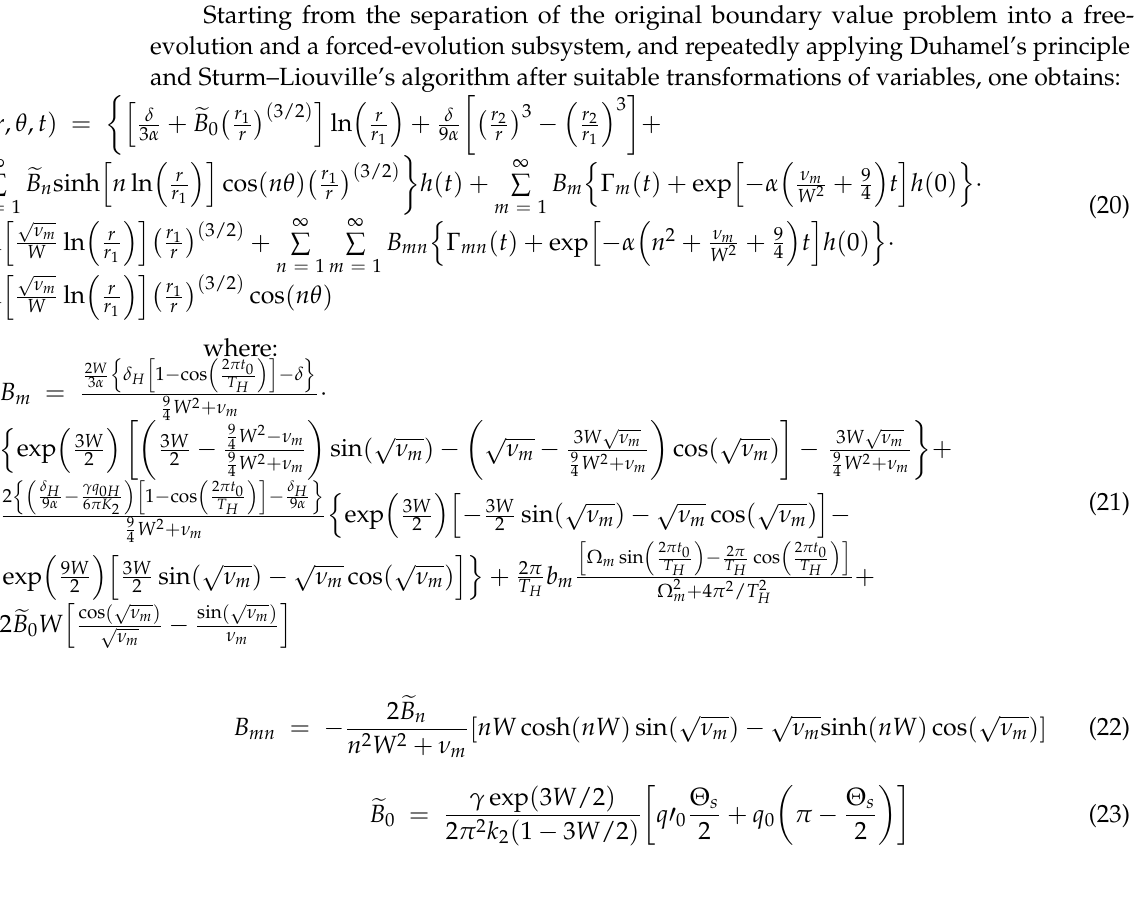
sion has to be intended as taking place without the activation of collateral feeding circuits.